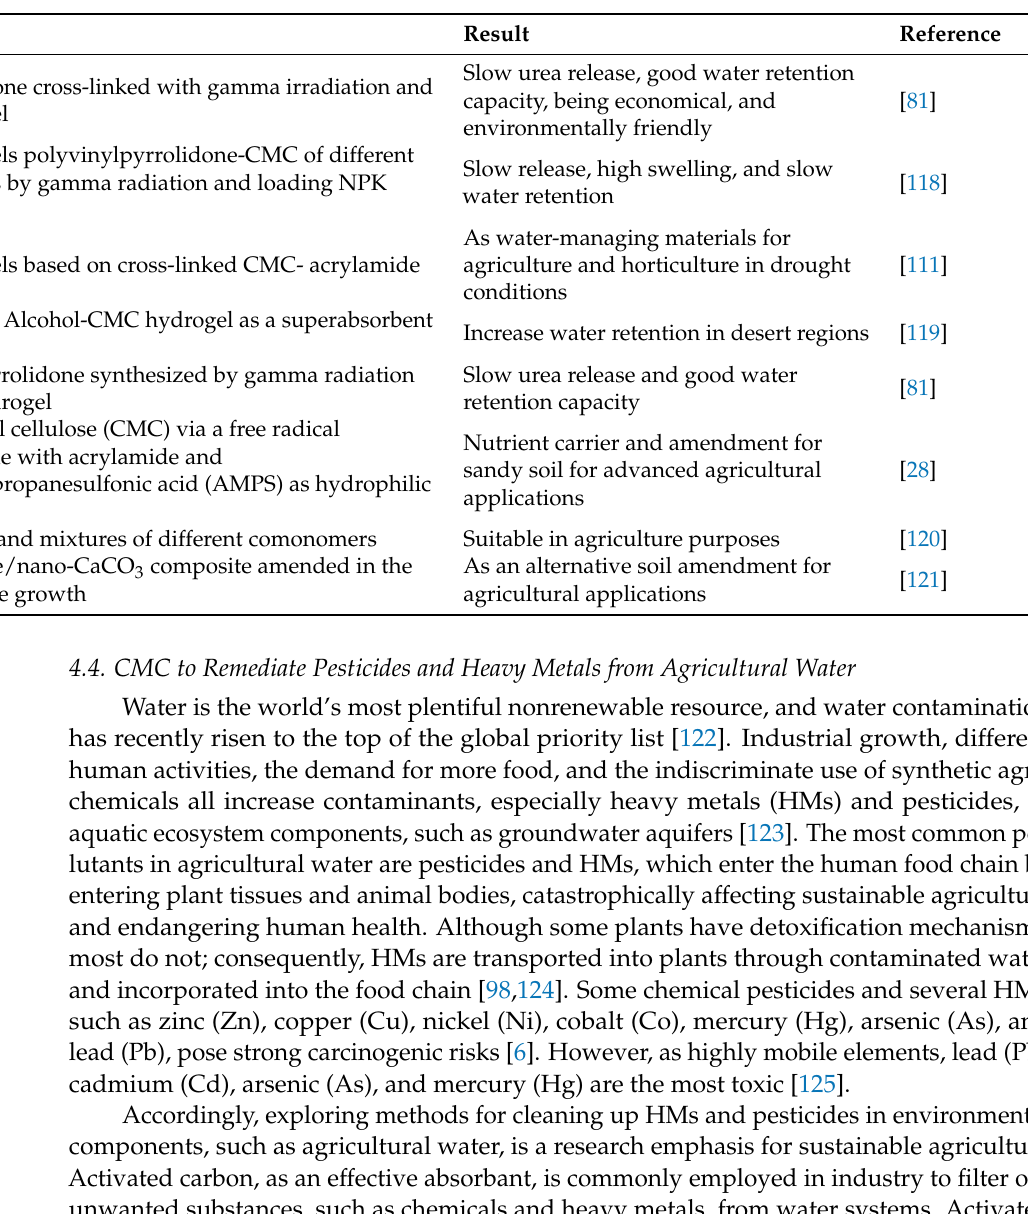
Table 5. Application of CMC as a superabsorbent